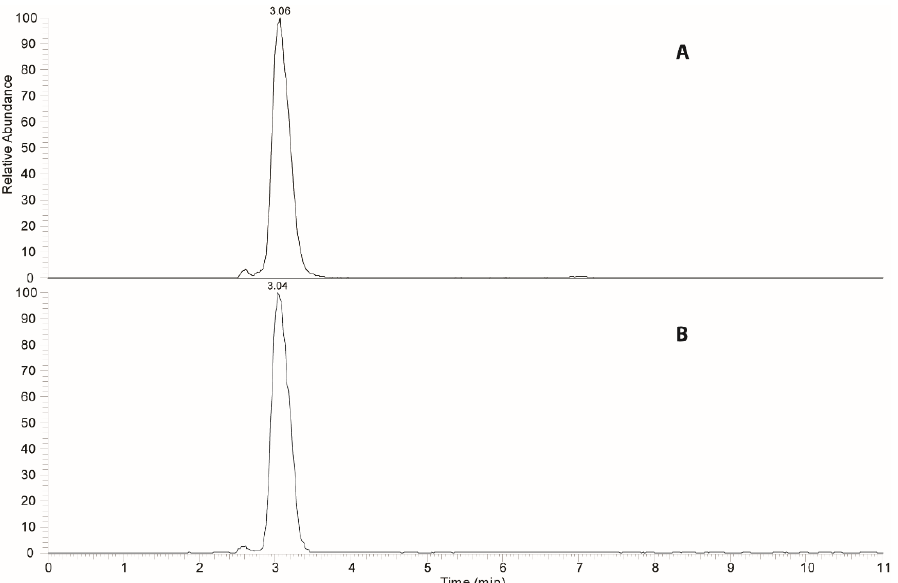
Figure 2. Multiple reaction monitoring chromatograms performed on a sample of enriched flour: ( A ) transition relative to hydroxytyrosol and ( B ) transition relative to d 2 -hydroxytytrosol (internal standard). Table 1. Amount of hydroxytyrosol transferred to food from a commercial olive oil and transfer yields. Amount of Hydroxytyrosol ( µ g)